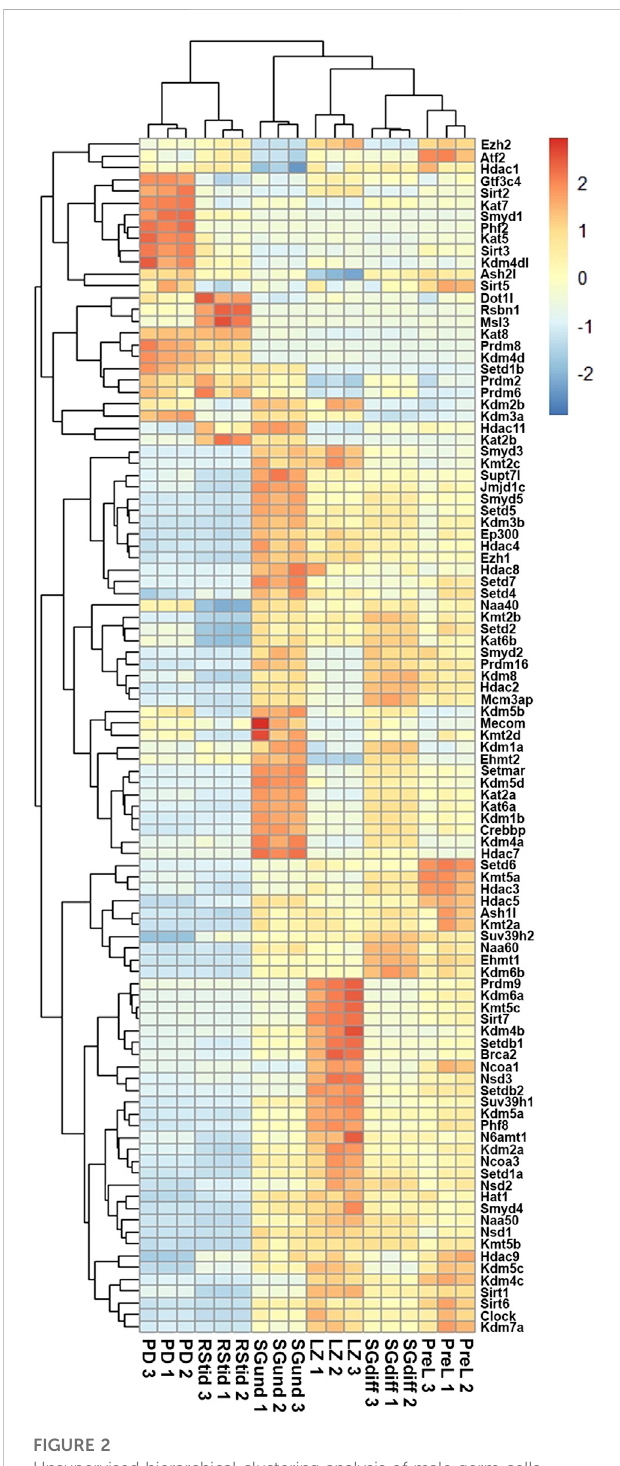
FIGURE 2 Unsupervised hierarchical clustering analysis of male germ cells transcriptome.Heatmapshowingz-scorevaluesofhistoneKacetylation and methylation writer/eraser enzymes. SGund: spermatogonia Kit-, SGdiff: spermatogonia Kit+, PreL: pre-leptotene spermatocytes, LZ: leptotene/zygotene spermatocytes, PD: pachytene/diplotene spermatocytes, RStid: round